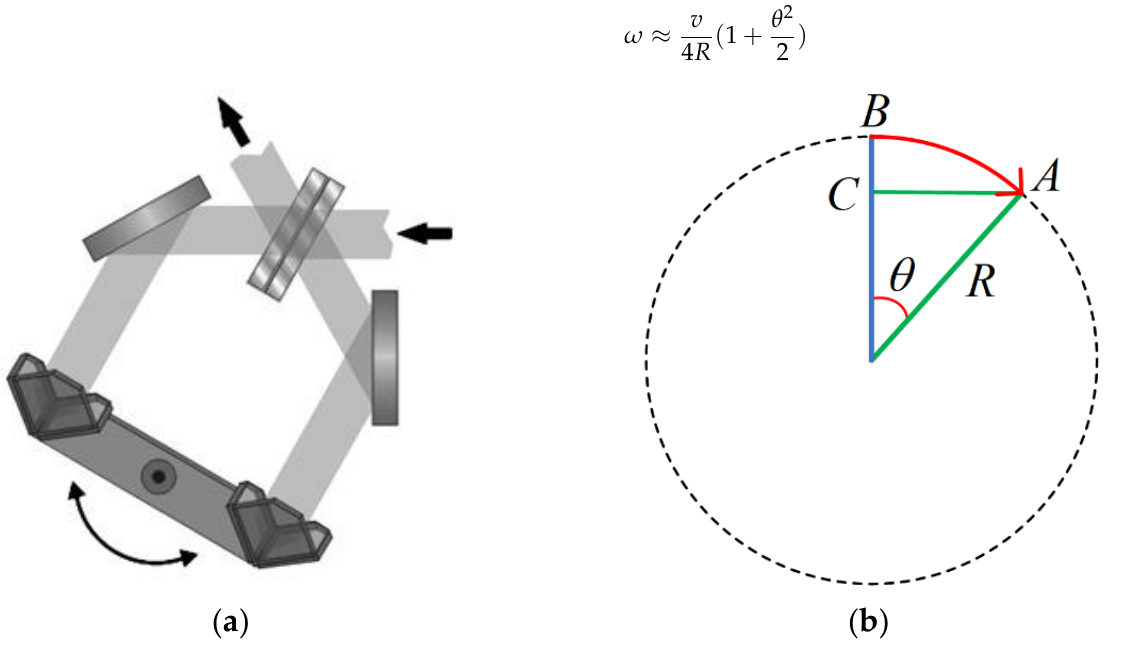
Figure 3. ( a ) The double moving mirror torsion pendulum structure. ( b ) A schematic diagram of the relationship between the OPD and the swing angle.